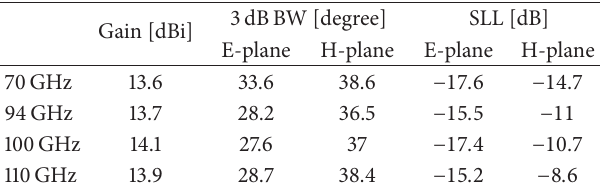
Table 1: Performance summary of the proposed